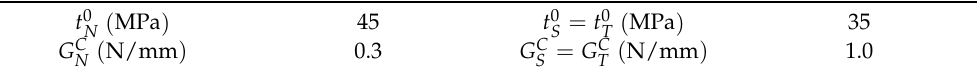
Table 4. Interface properties of the five-harness SiC f /PyC/SiC satin weave composites [32]. ( MPa t 0 N